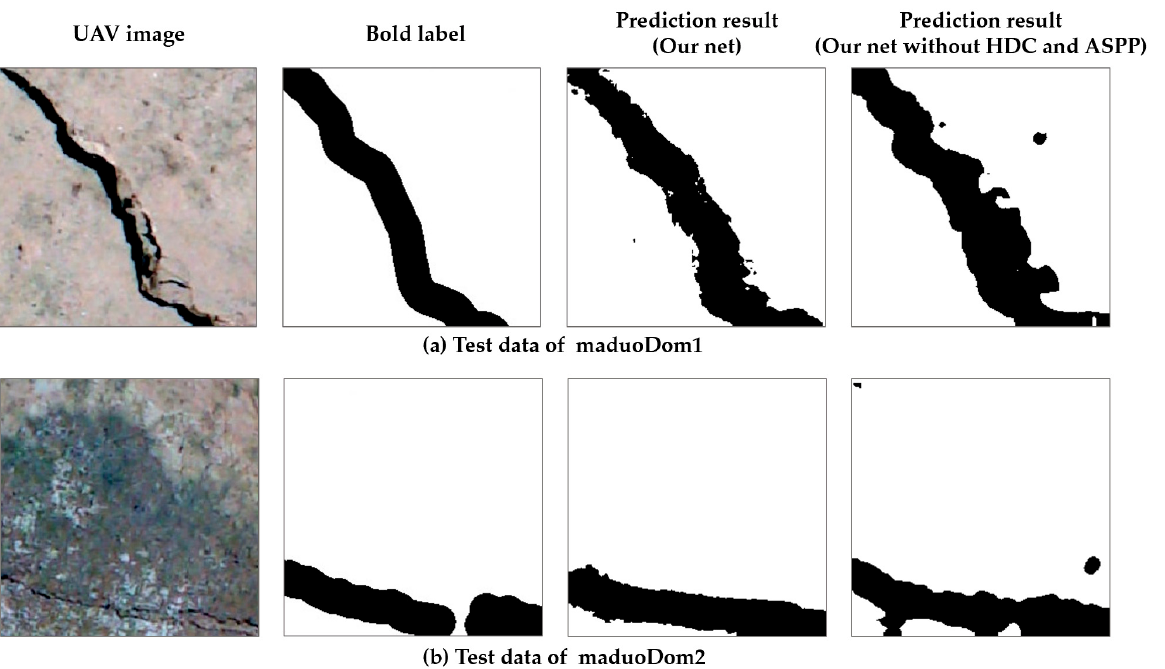
Figure 11. Prediction results of different network architectures for maduoDom1 and maduoDom2 with bold-labeled cracks. Table 2. Quantitative evaluation results of crack identification in the four datasets. Data